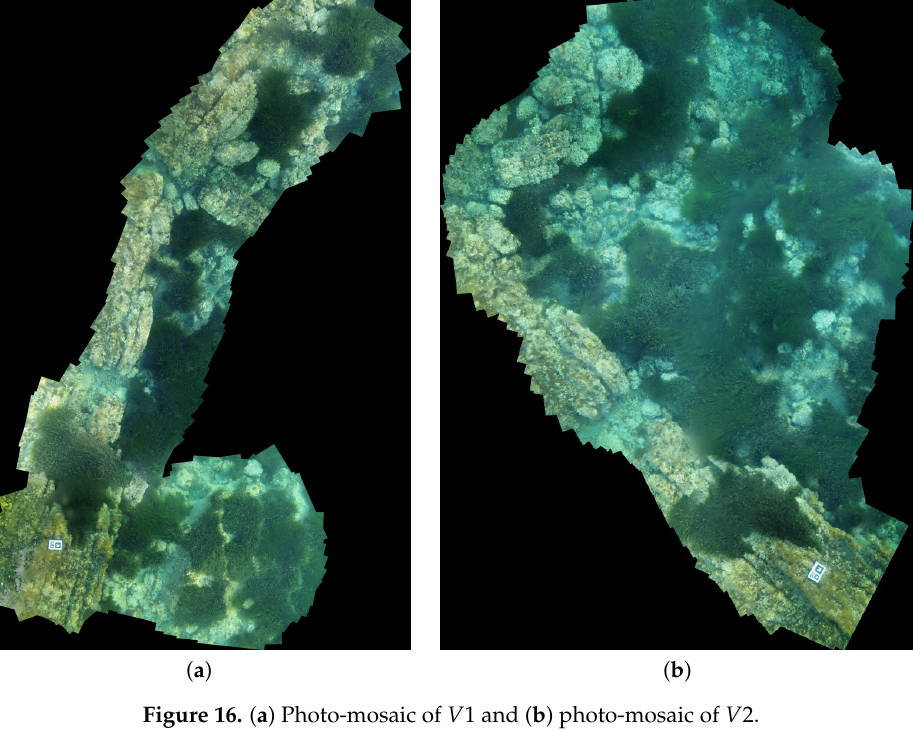
Figure 16. ( a ) Photo-mosaic of V 1 and ( b ) photo-mosaic of V 2.